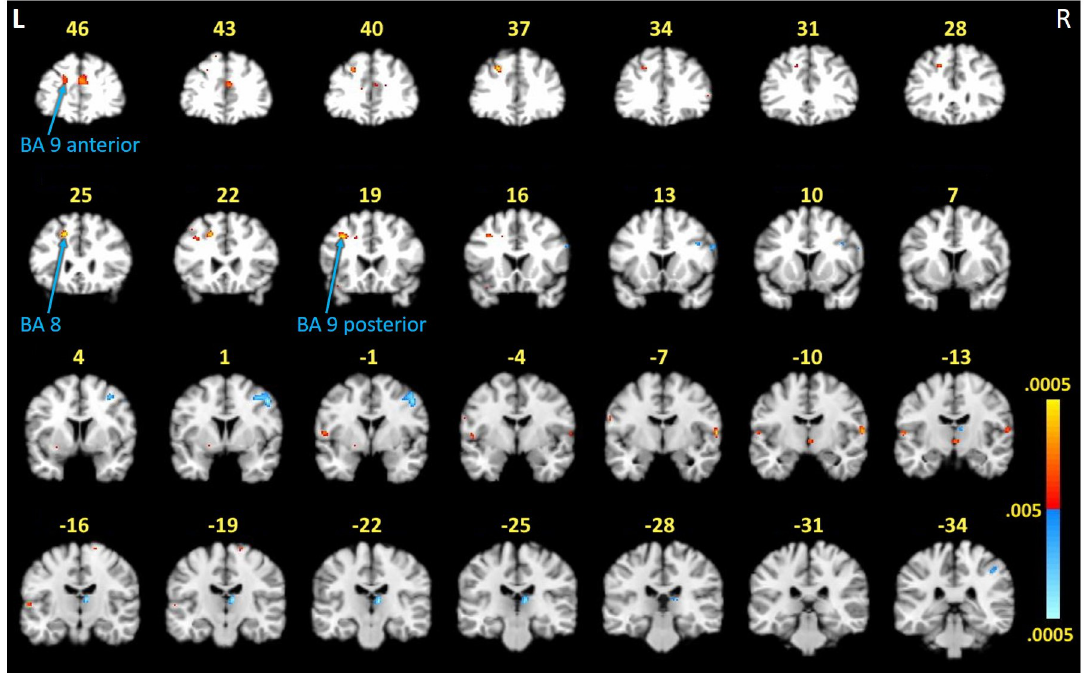
Fig 2. FMRI activation differences between study groups during the working memory task. Activations represent a double subtraction between groups (i.e., the difference between-groups of the difference within-groups [(forward, 2 stimulus) minus (control, 2 stimulus)]). Red indicates activity in PTLD > controls, except for where indicated in Table 2. Blue indicates activity in controls > PTLD. Areas of greater activation in control participants (blue) compared to PTLD participants were consistent with localized activity previously documented as relevant to task performance and reflected hypoactivity in these regions by the PTLD group [23]. Unexpectedly, three frontal lobe activations demonstrated by the PTLD group (red) were located primarily within white matter. Numbers denote y -axis on the MNI template. Color scale represents .005 < p < .0005. L = left, R = right hemispheres.